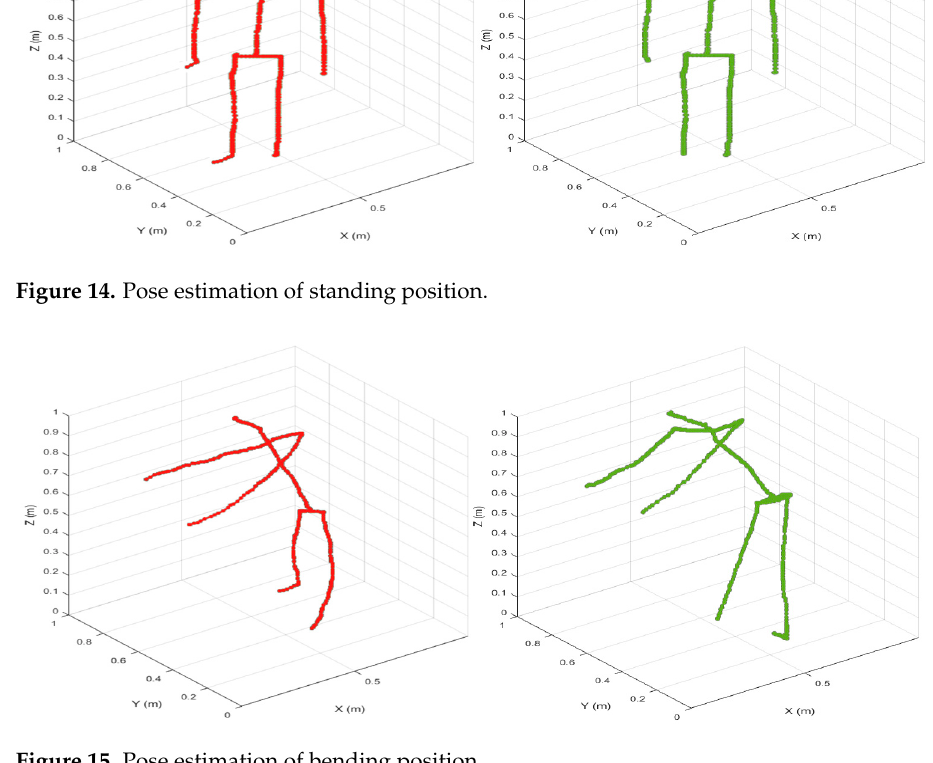
Figure 16. Pose estimation of sitting position.